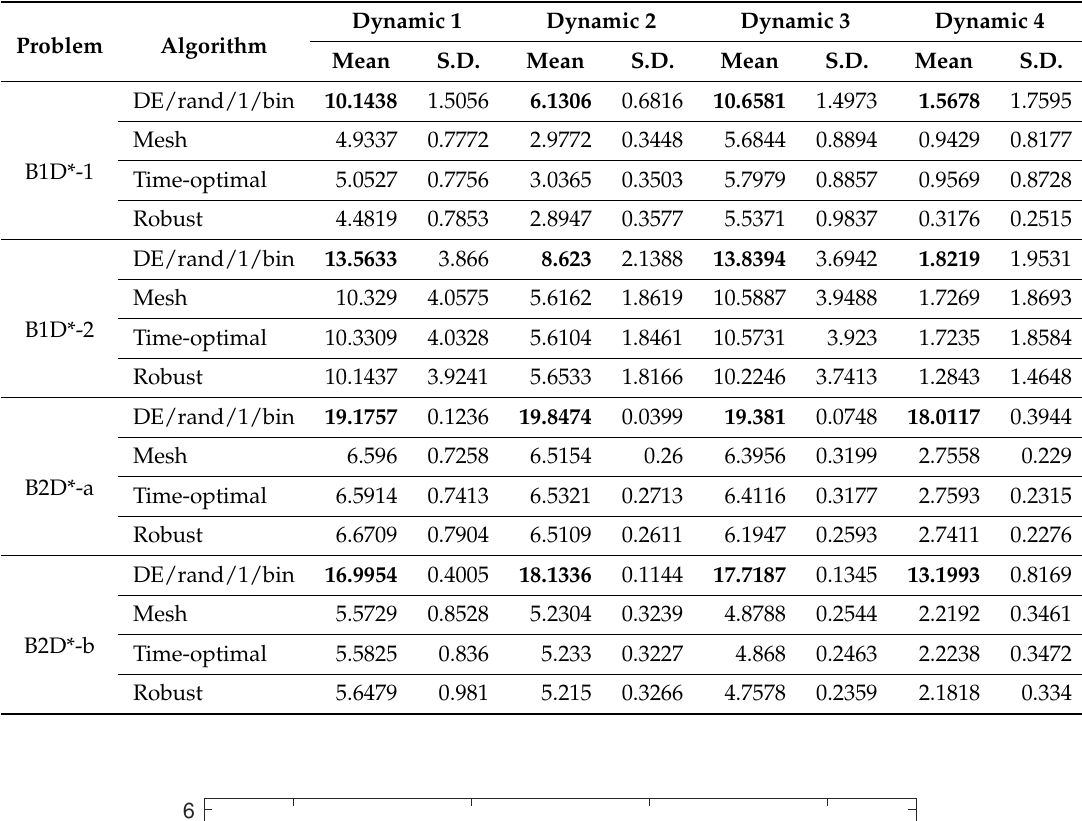
Table 7. Statistical Results obtained by each Algorithm in each one of the problem instances. Best statistical results are marked with boldface.